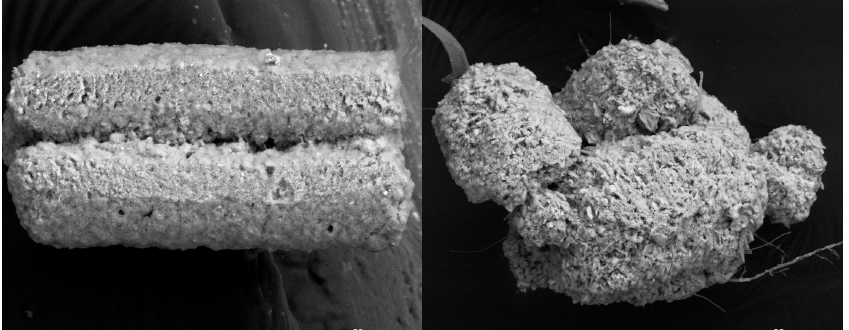
Figure 8. SEM photos of feces pellets of Asellus aquaticus . Left: fresh released Asellus aquaticus feces, right: feces pellets after 42 days in a laboratory tap water flow-through experimental device.